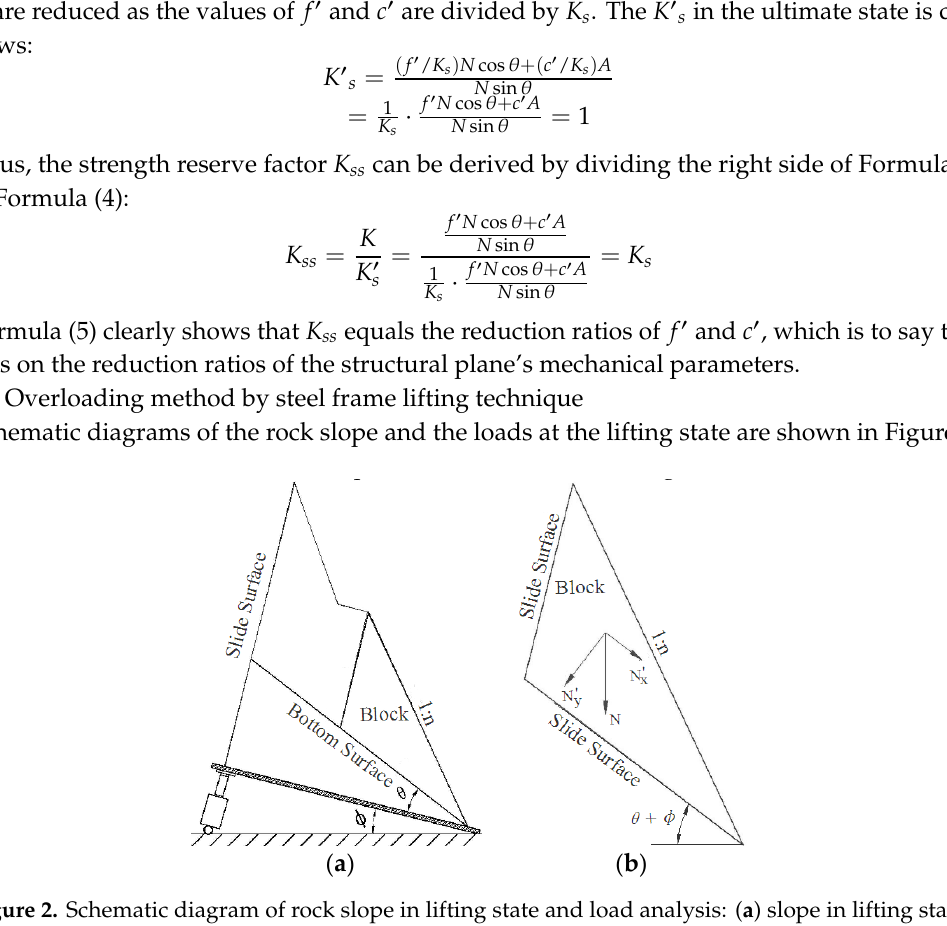
Figure 2. Schematic diagram of rock slope in lifting state and load analysis: ( a ) slope in lifting state; ( b ) load analysis.